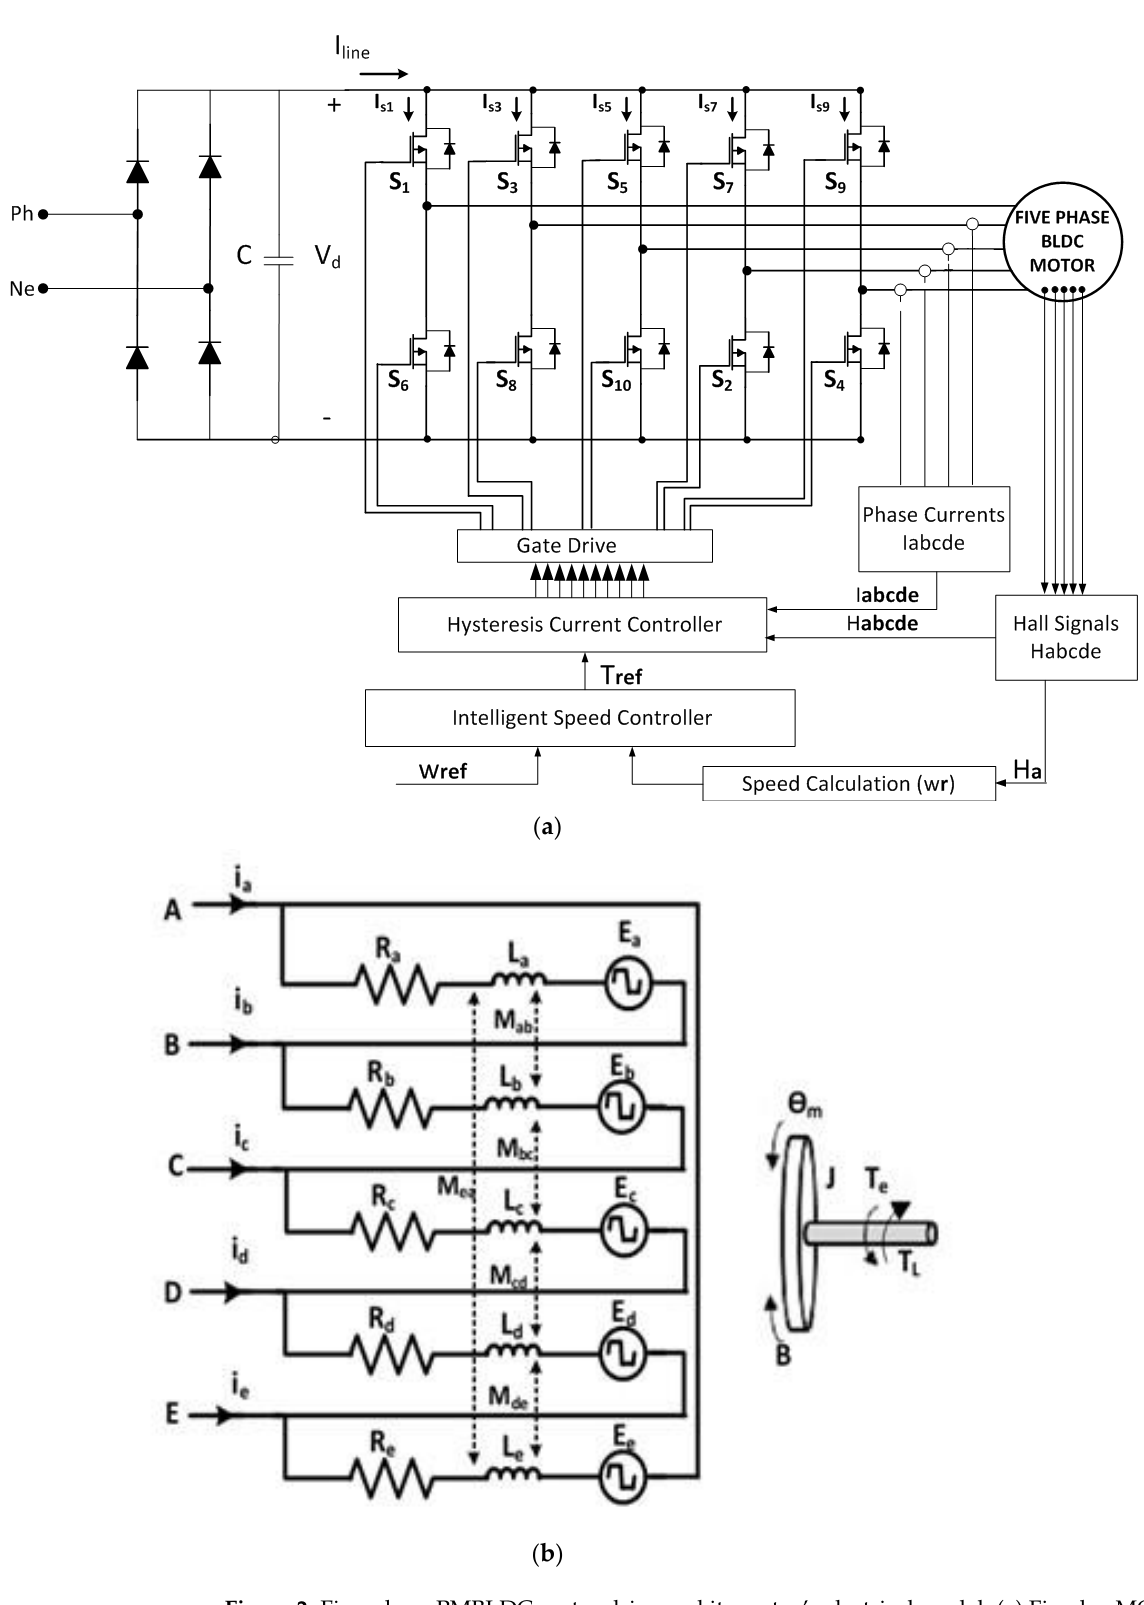
Figure 2. Five-phase PMBLDC motor drive and its motor’s electrical model. ( a ) Five-leg MOSFET inverter-fed BLDC motor drive. ( b ) Equivalent electrical model of the motor.